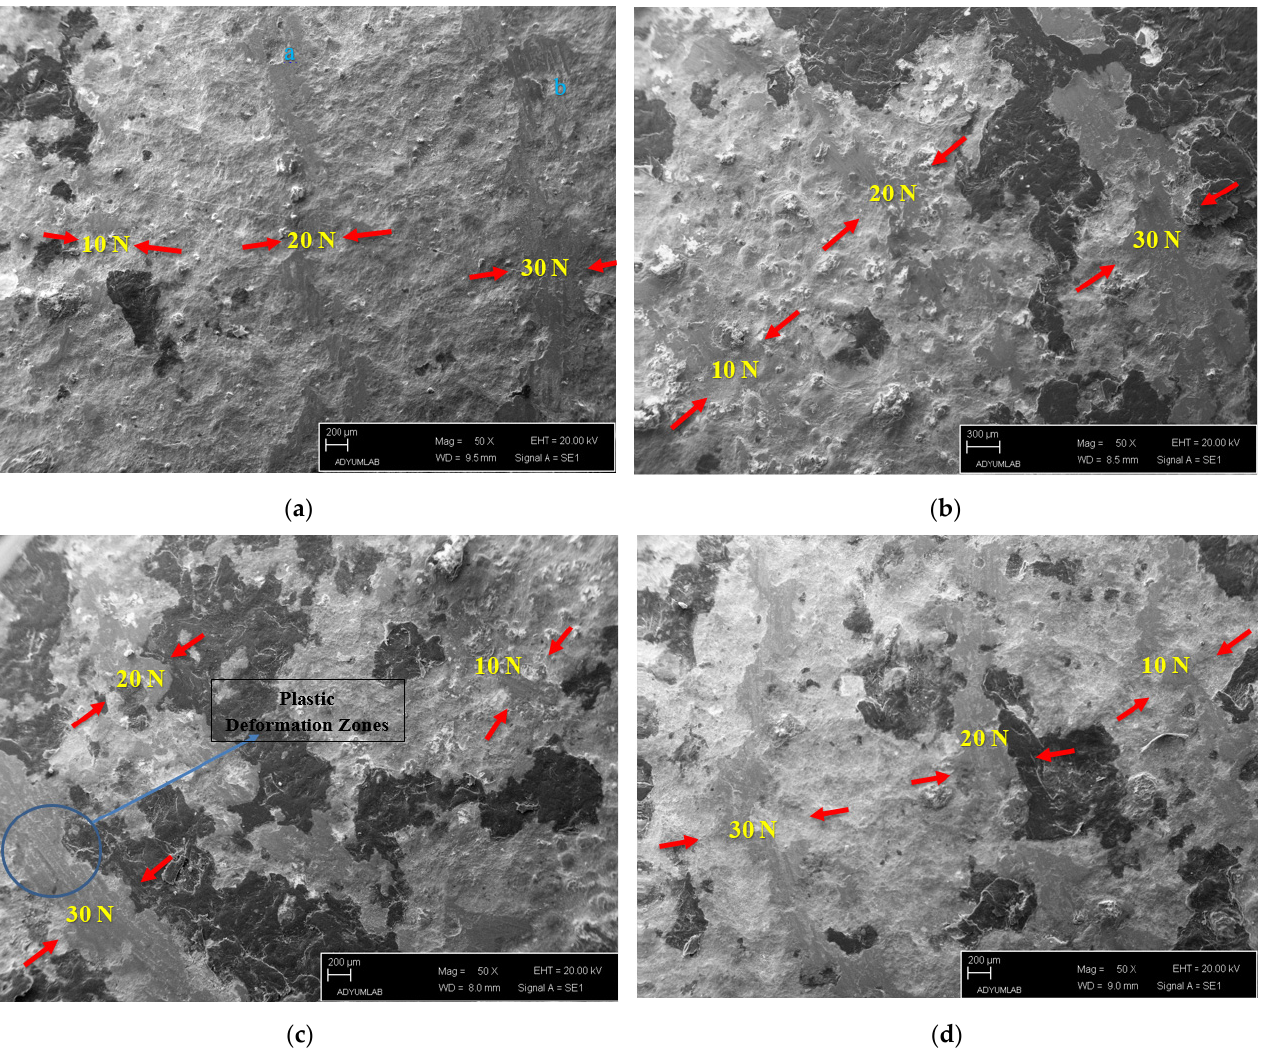
Figure 4. ( a ) SEM of worn Ti60Si15Zn20Al5 material, ( b ) SEM of worn Ti55Si15Zn20Al10 material, ( c ) SEM of worn Ti45Si15Zn20Al20 material and ( d ) SEM of worn Ti60Si20Zn20 material.